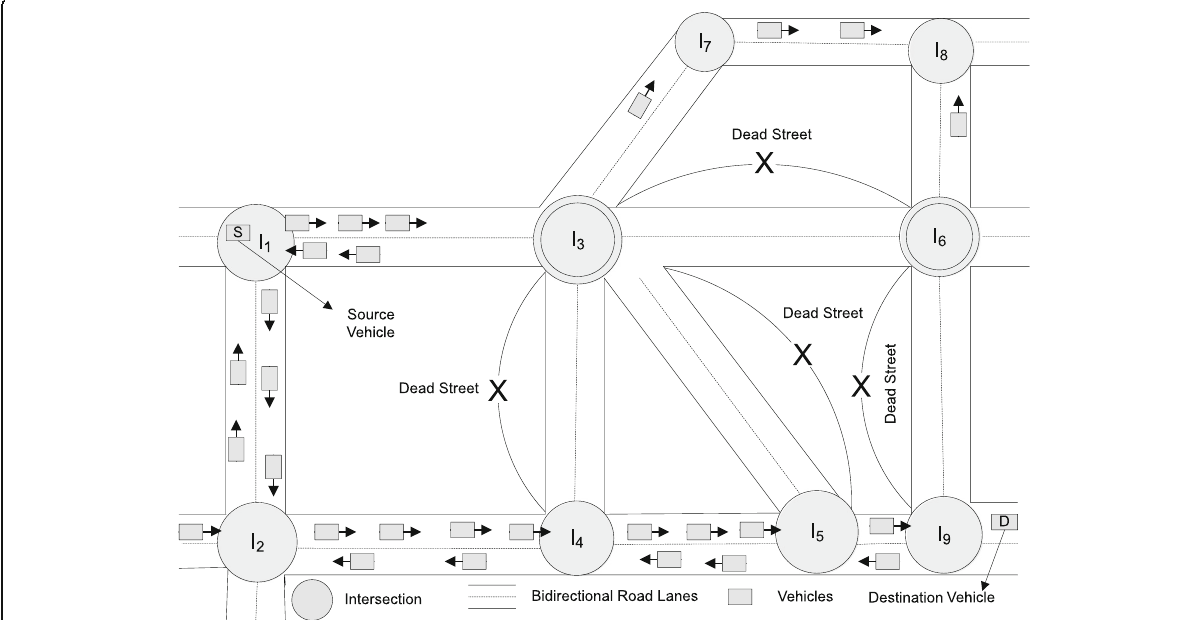
Fig. 2 The problem scenario. Each circle represents a junction. Double lines represent bidirectional two-lane roads, and the small rectangular box with arrow represents vehicular node moving in the direction of the arrow, S represents source vehicle, and D indicates the